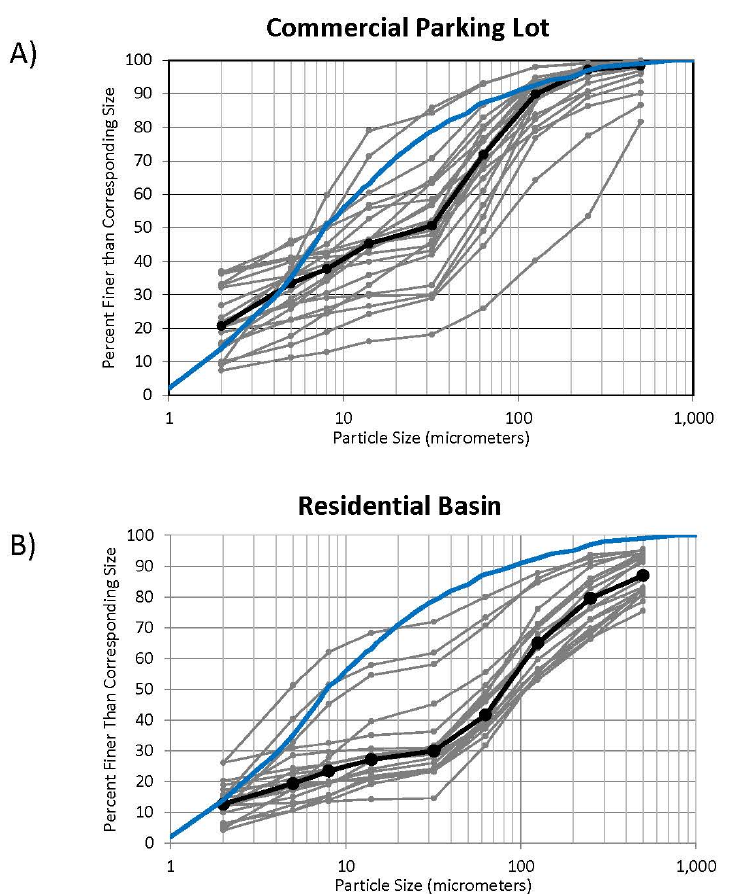
Figure 2. Individual event and median (bold) particle size distributions measured at the commercial parking lot ( A ) ( n = 20) and residential basin ( B ) ( n = 19) compared to the Nationwide Urban Runoff Program (NURP) (blue).